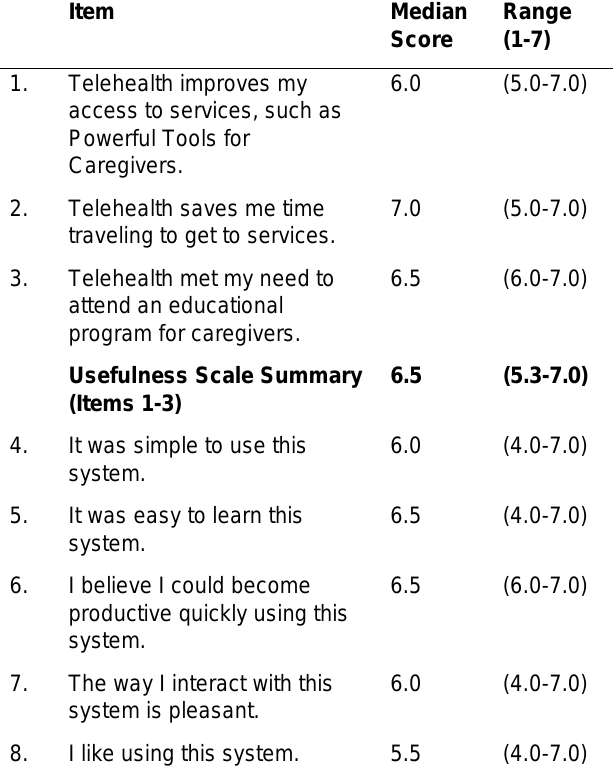
Table 2. Telehealth System Usability as Indicated